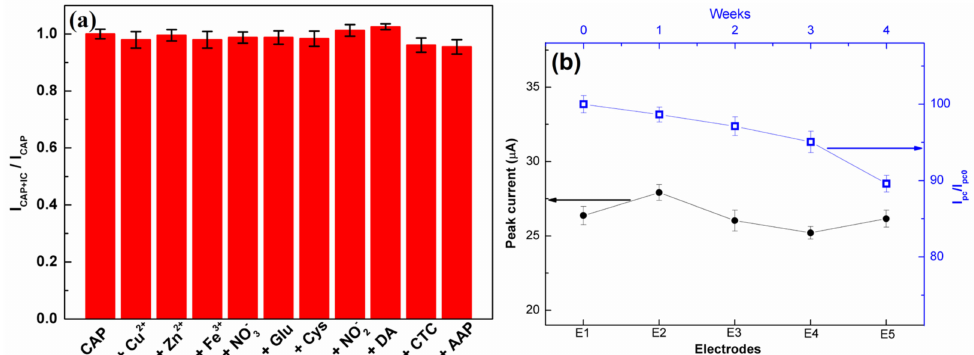
Figure 9. ( a ) Anti-interference ability of C-BN/GCE in the determination of CAP (50 µ M CAP, 10-fold concentrations of Zn 2+ , Cu 2+ , Fe 3+ , NO 3 − , glucose, Cys, NO 2 − , DA, CTC, and AAP; ( b ) Left (black curve): Reproducibility of the proposed sensor; Right (blue curve): Evaluation of the long-term stability of the proposed sensor for four weeks (Circle and square symbols are experimental